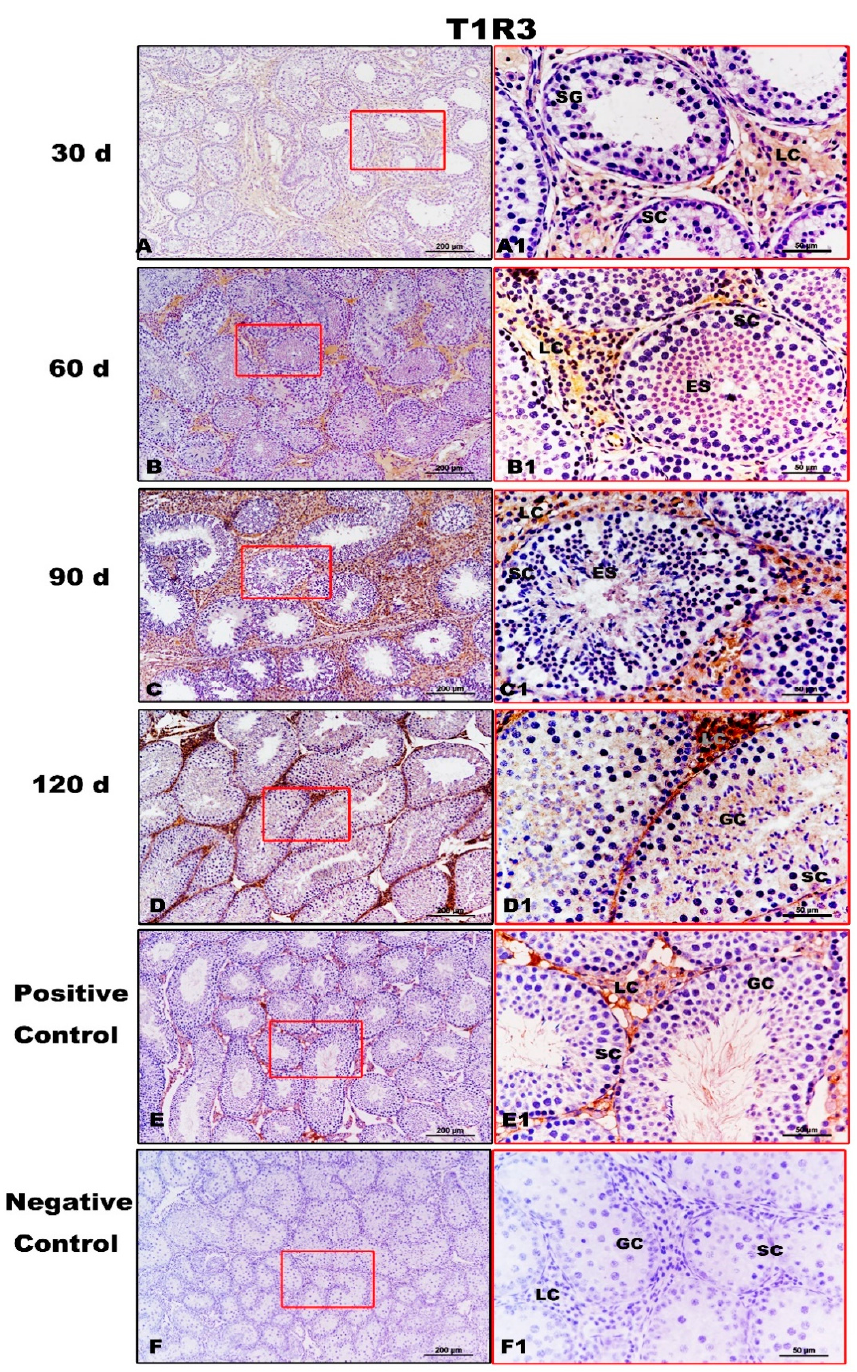
Figure 5. Immunolocalization of T1R3 protein in testes of Congjiang Xiang pigs during development. ( A – F ) represent the testis sections immunostained with primary antibody of T1R3 in 30-day-old Congjiang Xiang pigs, 60-day-old Congjiang Xiang pigs, 90-day-old Congjiang Xiang pigs, 120-day-old Congjiang Xiang pigs, positive control, and negative control groups ( n ≥ 3/group), respectively. Picture ( E ), the mouse testis sections (at 60 day) were used as a positive control for T1R3. Picture ( F ), negative control, was performed with PBS instead of the primary antiserum of T1R3 (30 day Congjiang Xiang pig testes). Leydig cells (LC); Sertoli cells (SC); germ cells (GC); spermatogonia (SG); spermatocytes (P); elongating/elongated spermatids (ES). Pictures ( A – F ) marked by square boxes of red color, the boxes are enlarged beside and marked as ( A1 – F1 ). Scale bars: A1–F1 = 200 µ m (100 × magnification), A–F = 50 µ m (400 ×